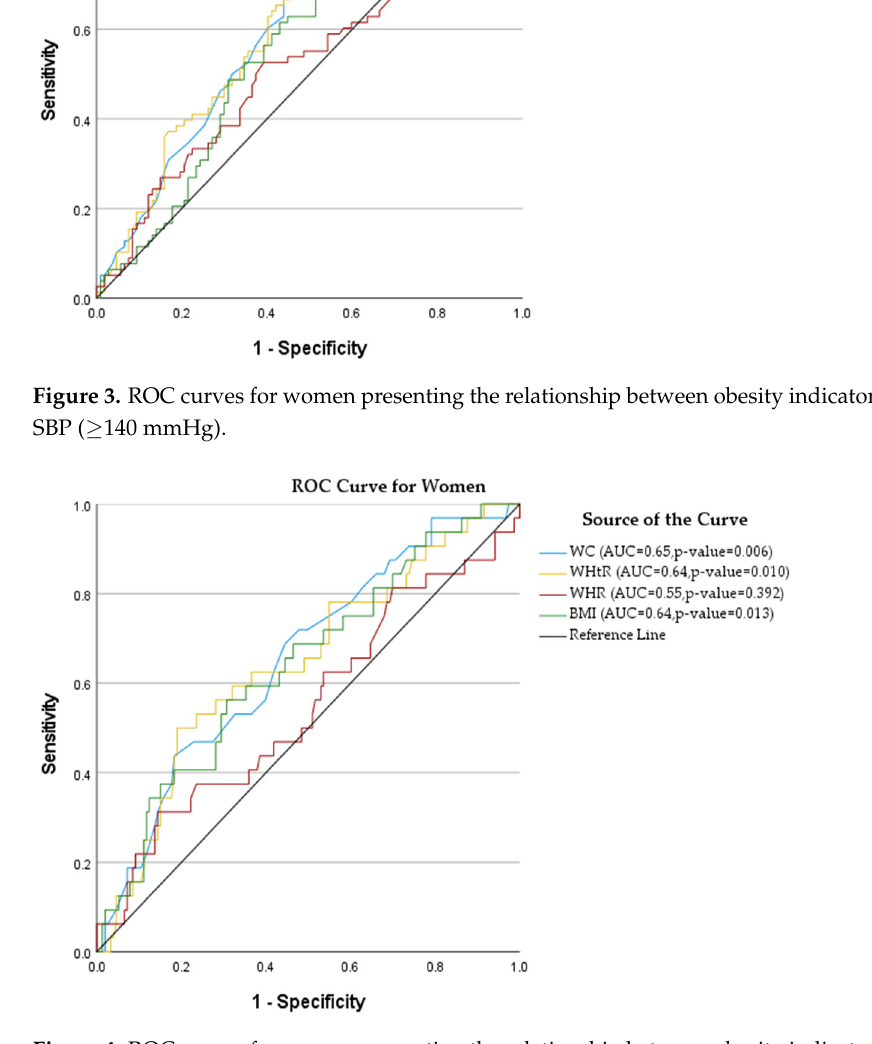
Figure 4. ROC curves for women presenting the relationship between obesity indicators and elevated DBP ( ≥ 90 mmHg).